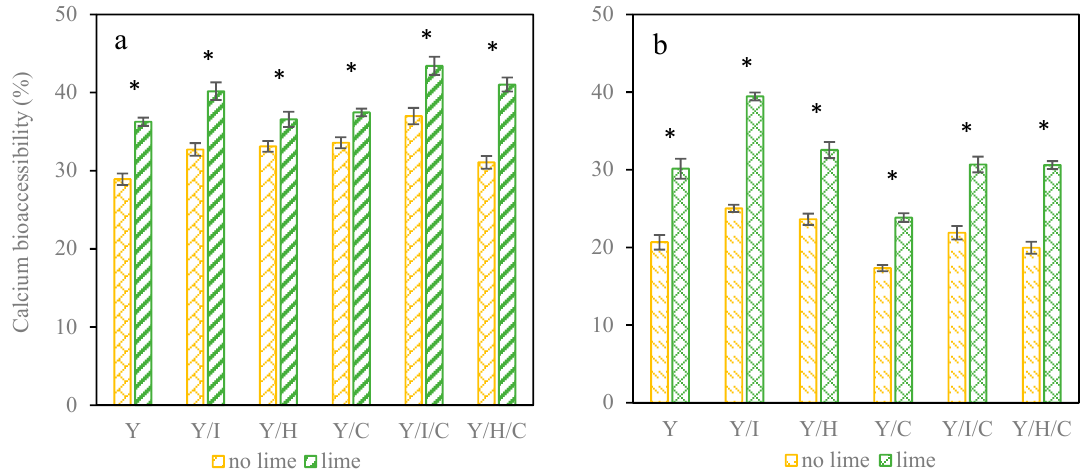
Figure 3. Calcium bioaccessibility ( a ) at the beginning; ( b ) at the end of intestinal phase. * indicated significant differences of lime juice addition in Tukey ( p < 0.05).